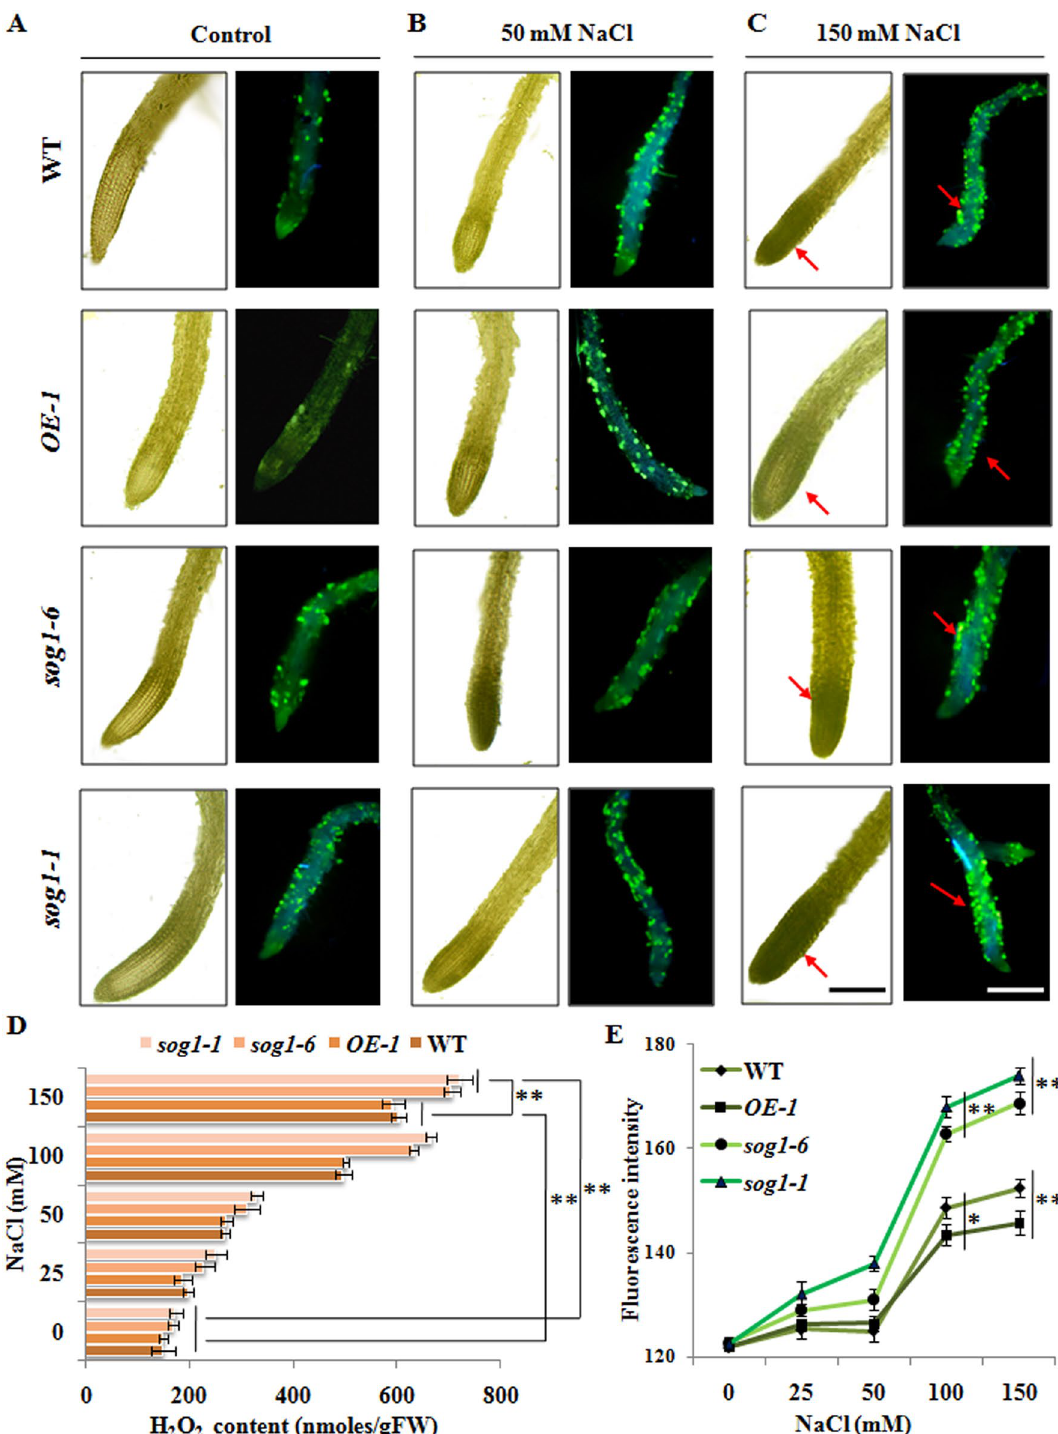
Figure 2. Salinity mediated induction of oxidative stress. ( A – C , left panels) Qualitative analysis of H 2 O 2 accumulation levels in the roots of 7-days old wild-type, OE-1 , sog1-6 and sog1-1 mutant lines in the absence and presence of 50 and 150 mM NaCl, respectively. ( A – C , right panels) Localization of superoxide radicals by ROS imaging using CM-H 2 DCFDA in root tips of all the genotypes in absence and presence of NaCl. Dark regions and green patches indicated by the arrow heads showing H 2 O 2 accumulation and ROS generation, respectively. Representative images from at least three independent experiments with similar results are shown. ( D , E ) Quantitative estimation of H 2 O 2 content and total ROS in the roots of 7-days old wild-type, OE-1 , sog1-6 and sog1 -1 mutant line seedlings, either untreated or treated with increasing concentrations of NaCl. Quantitative data has been represented as the mean value of three independent biological replicates. Error bars represent standard deviation. Asterisks represent statistically significant differences (* p < 0.05, ** p < 0.01) relative to